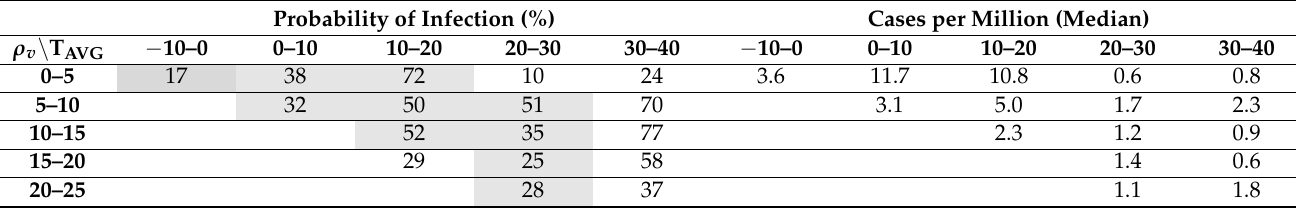
Table 2. Probability of infection (estimated from event occurrence) and human cases per million (estimated from de- tected cases) with respect to temperature and absolute humidity, based on reported COVID-19 human cases worldwide (01/01/2020–07/05/2020). Shaded cells contain more than 5% of the